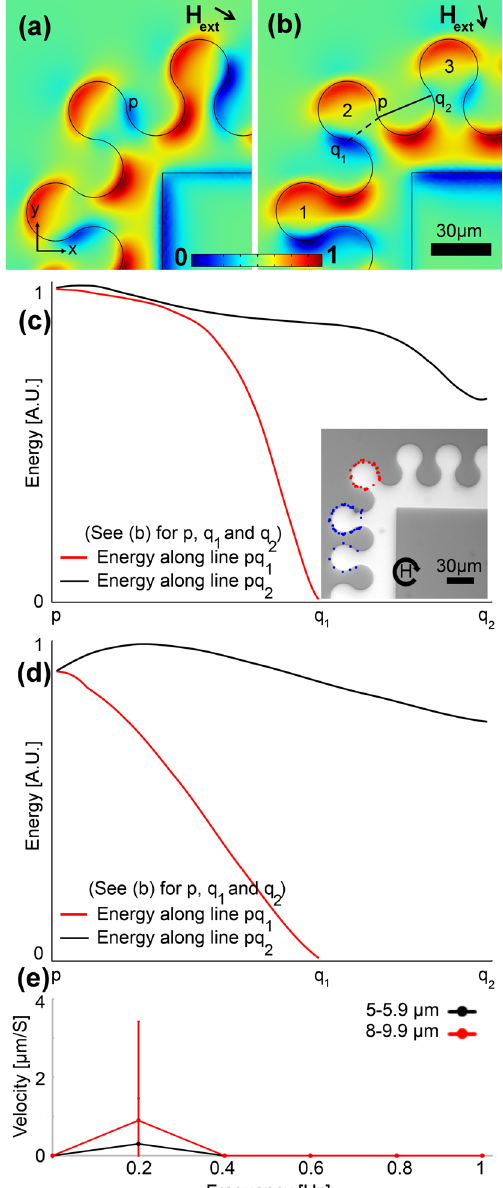
Figure 3. A sample inappropriate magnetophoretic bend design. ( a , b ) The magnetic energy landscape simulation results above the substrate for a sample bend are illustrated. The blue and red areas stand for the regions with low and high magnetic energies, respectively. The black arrow depicts the in-plane magnetic field direction, in addition to which a vertical bias field is applied. Here, we did a min–max normalization to scale the magnetic energy between 0 and 1 (see the legend). The magnetic energies along the pq 1 and pq 2 lines in ( b ) (i.e., the dashed and solid lines) are plotted with the red and black curves for particles with a diameter of ( c ) 5 µm and ( d ) 20 µm. The inset illustrates the experimental trajectories for two sample particles at a frequency of 0.2 Hz with blue and red dotted lines, respectively. The circular arrow in the inset depicts the magnetic field rotation. The goal is to transport the particles from magnet 1 to magnet 3 through magnet 2. We used a linear scale for the magnetic energy plots and we did a min–max normalization, using the minimum and maximum of the magnetic energy along the pq 1 and pq 2 paths, to scale the energy between 0 and 1. ( e ) The particle velocity versus frequency of the externally applied magnetic field is plotted with the black and red curves for two particle sets with sizes in the ranges of 5–5.9 µm and 8–9.9 µm, respectively. The error bars show standard